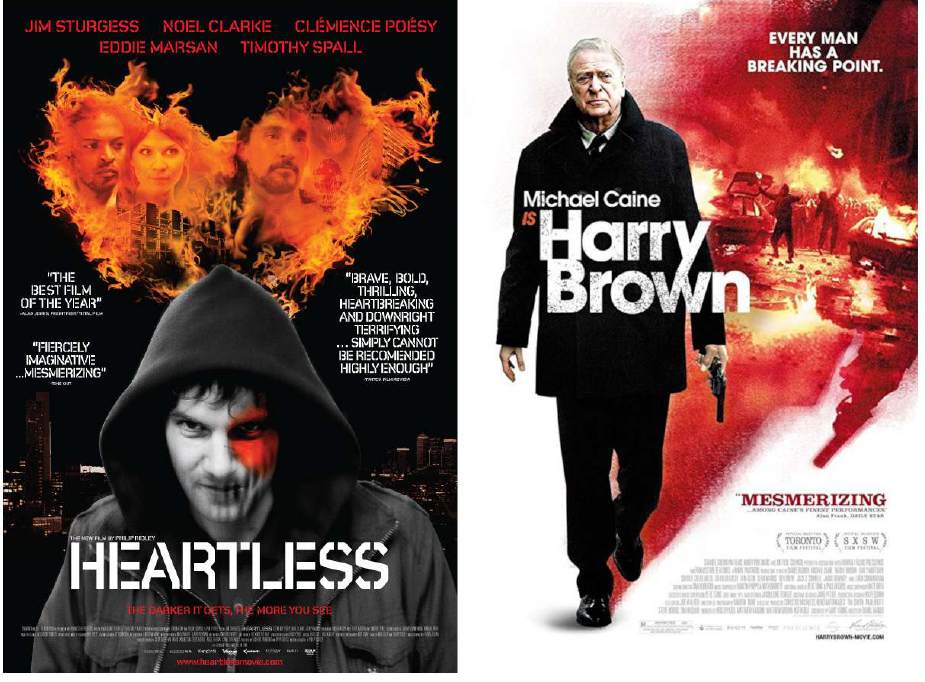
Figure 5. Social cleansing and scorched earth